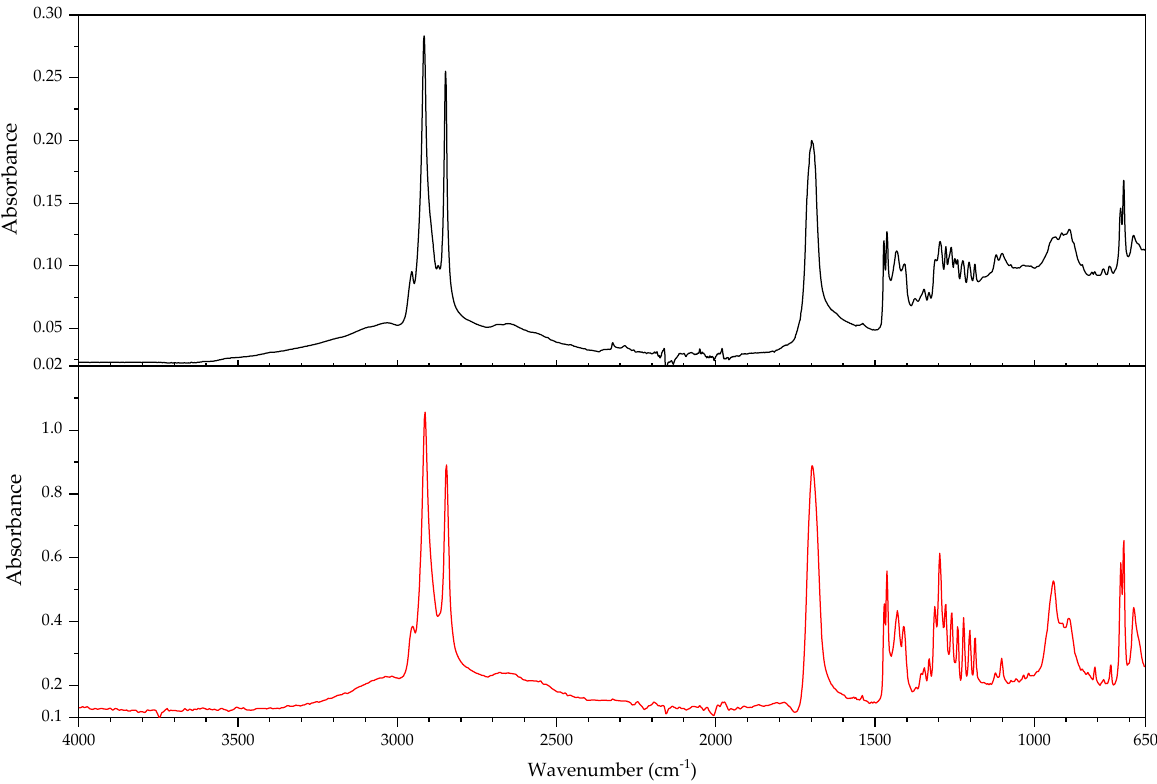
Figure 20. FTIR spectrum of sample 63 (black line) compared to reference spectrum of stearic acid (red line) from a commercial database.